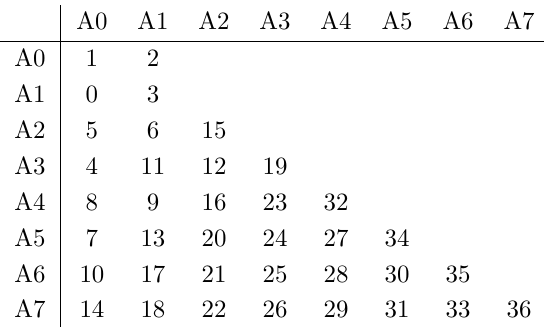
Table 3: Sequence of executing the partial product words A i × A j used for schoolbook squaring of 256 bit operands